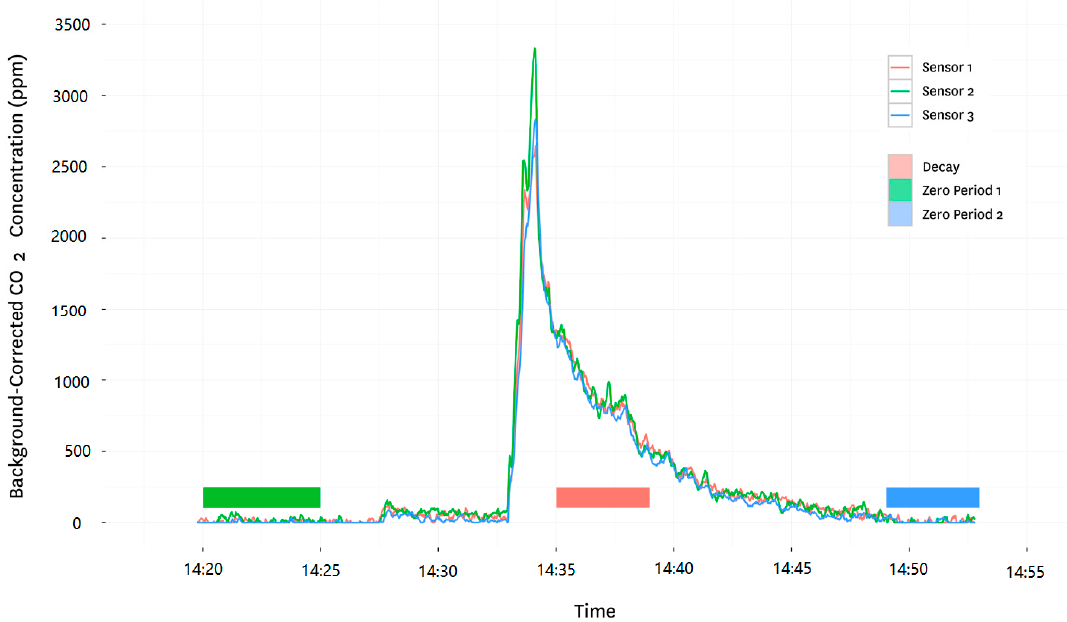
Figure 7. Sample ARMs trace from a single measurement period in a rural Nepali kitchen. A line was fit to the long-transformed values during the linear decay period (marked on the graph by the pink square) to estimate air changes per hour.